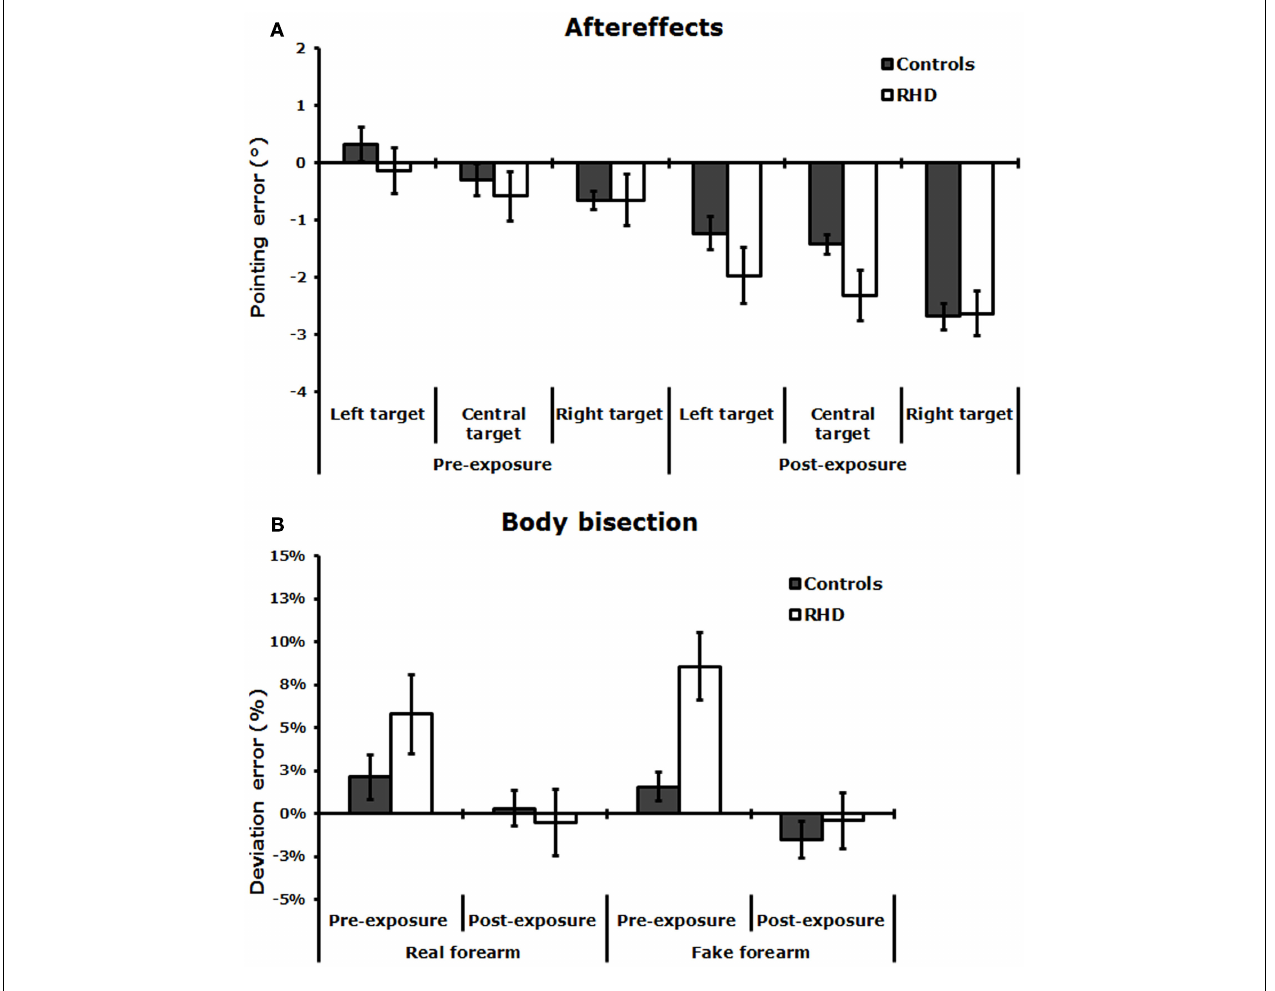
patients. (B) Mean percent deviation error ( ± SE) made by control participants and RHD patients, by stimulus condition (real and fake forearm), before and after